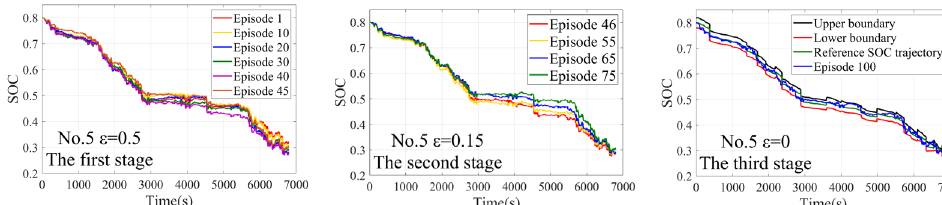
Figure 14. The training process of combined driving cycle 5.